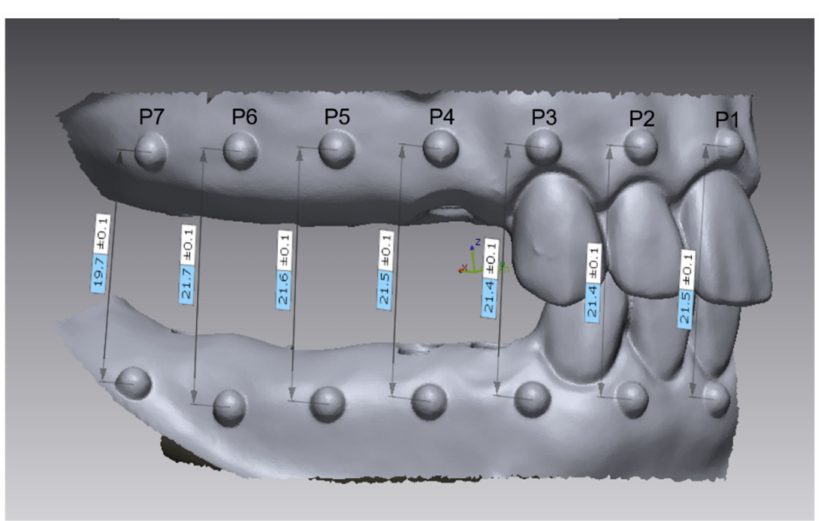
Figure 3. Linear measurements made using the “linear dimension” function after resegmenting a scan. Values are in